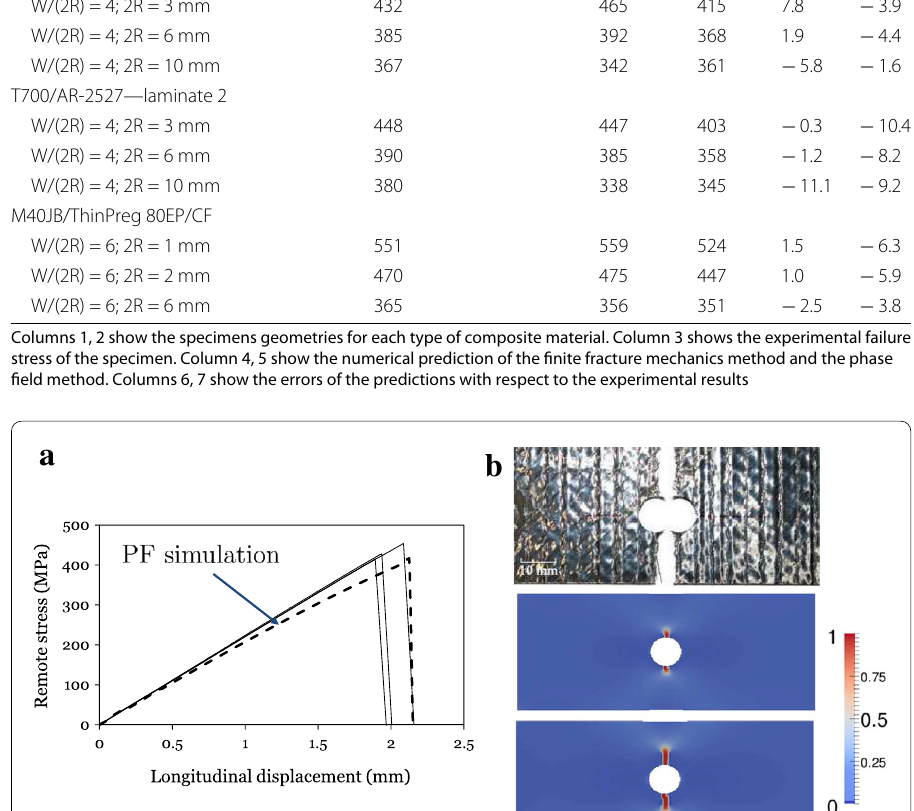
More applications of the finite elasticity solid shell element have been presented in